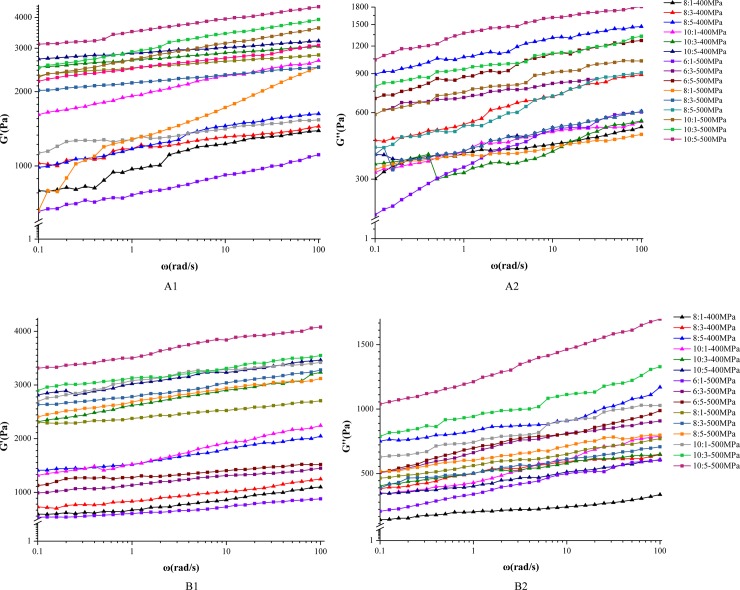
Frequency sweep curves (G' and G'') of β-glucan/ marine collagen peptide (OG-MCP) mixed gels at different pHs (A1 and A2, pH 6; B1 and B2, pH 3).